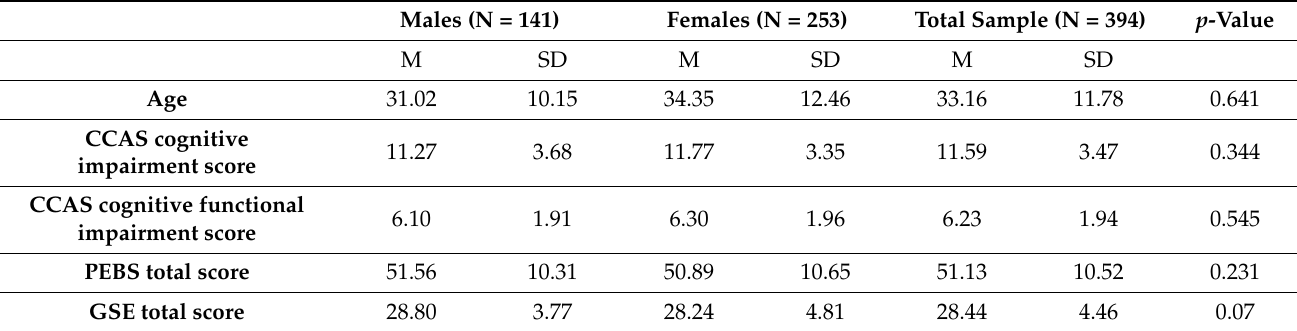
Table 1. Descriptive analysis for the study